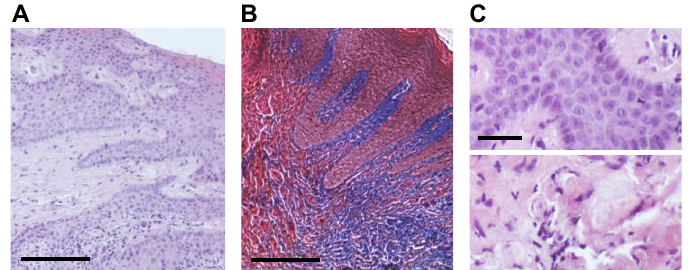
Figure 1. Histological characterization of gingival biopsies. ( A ) Representative photomicrograph of sections of gingival biopsies showing elongated and branched epithelial ridges and subjacent chorion full of a dense and homogeneous structure of collagen bundles. HE staining, scale bar 100 µ m. ( B ) Representative photomicrograph of sections of gingival biopsies showing collagen bundles in the deep chorion (blue). Trichromic Masson staining, scale bar 100 μm. ( C ) Representative photomicrographs of histological alterations observed in CHX biopsies, such as enlarged and polymorphic nuclei in the epithelial layer (upper panel) and enhanced fibrosis in the deep chorion (lower panel). HE staining, scale bar 25 μm.